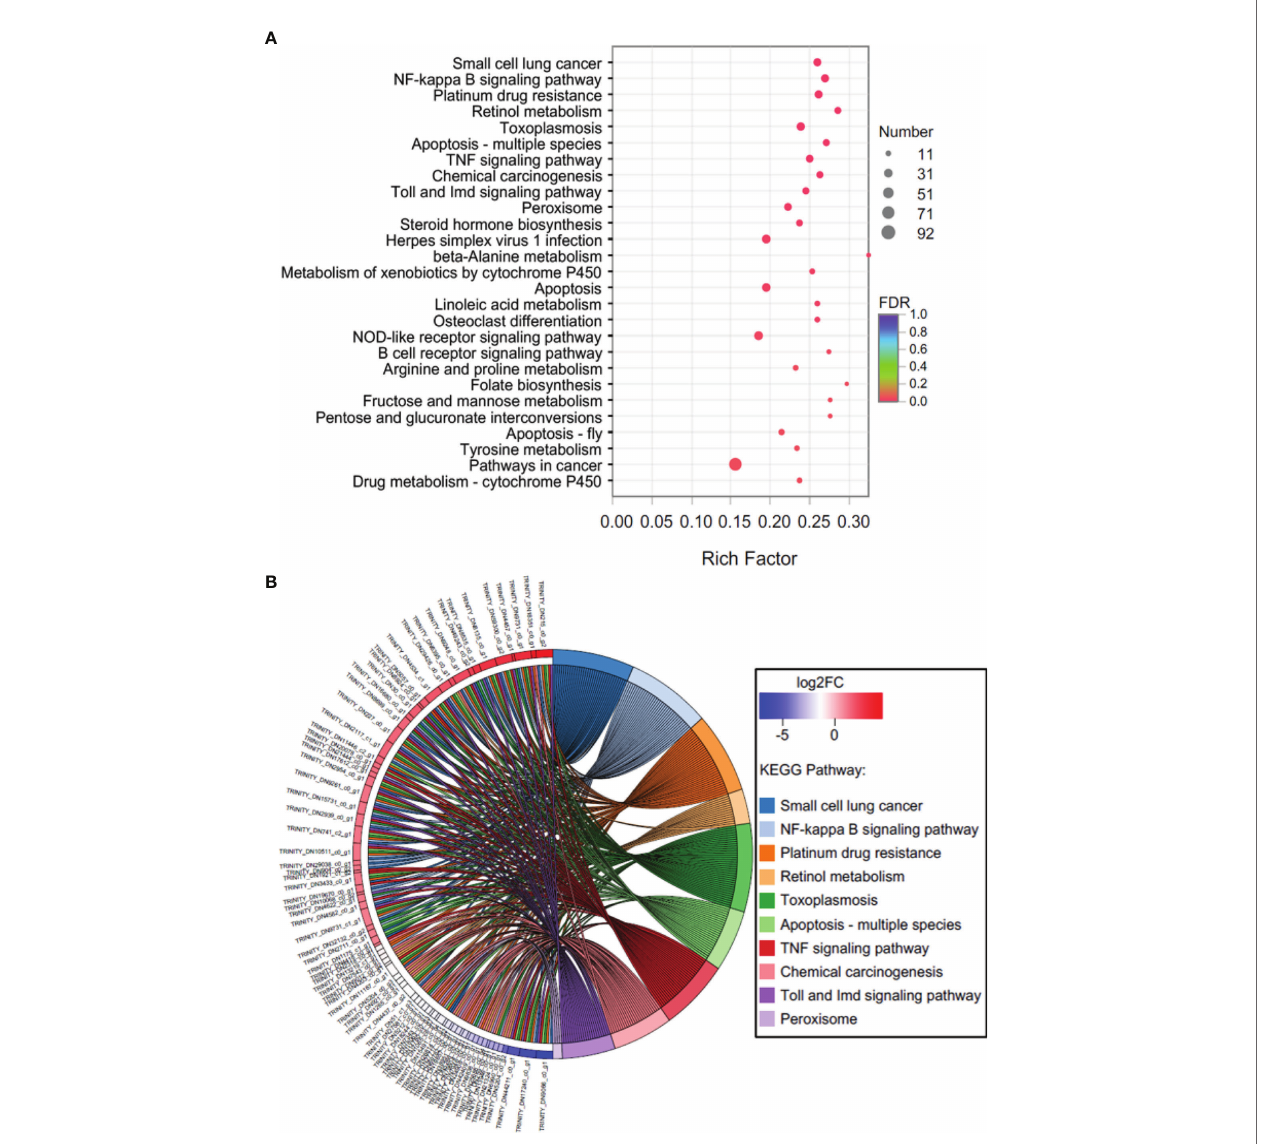
FIGURE 4 | KEGG enrichment analysis of DEGs in C vs. HS. (A) Bubble diagram, (B) enrichment chord